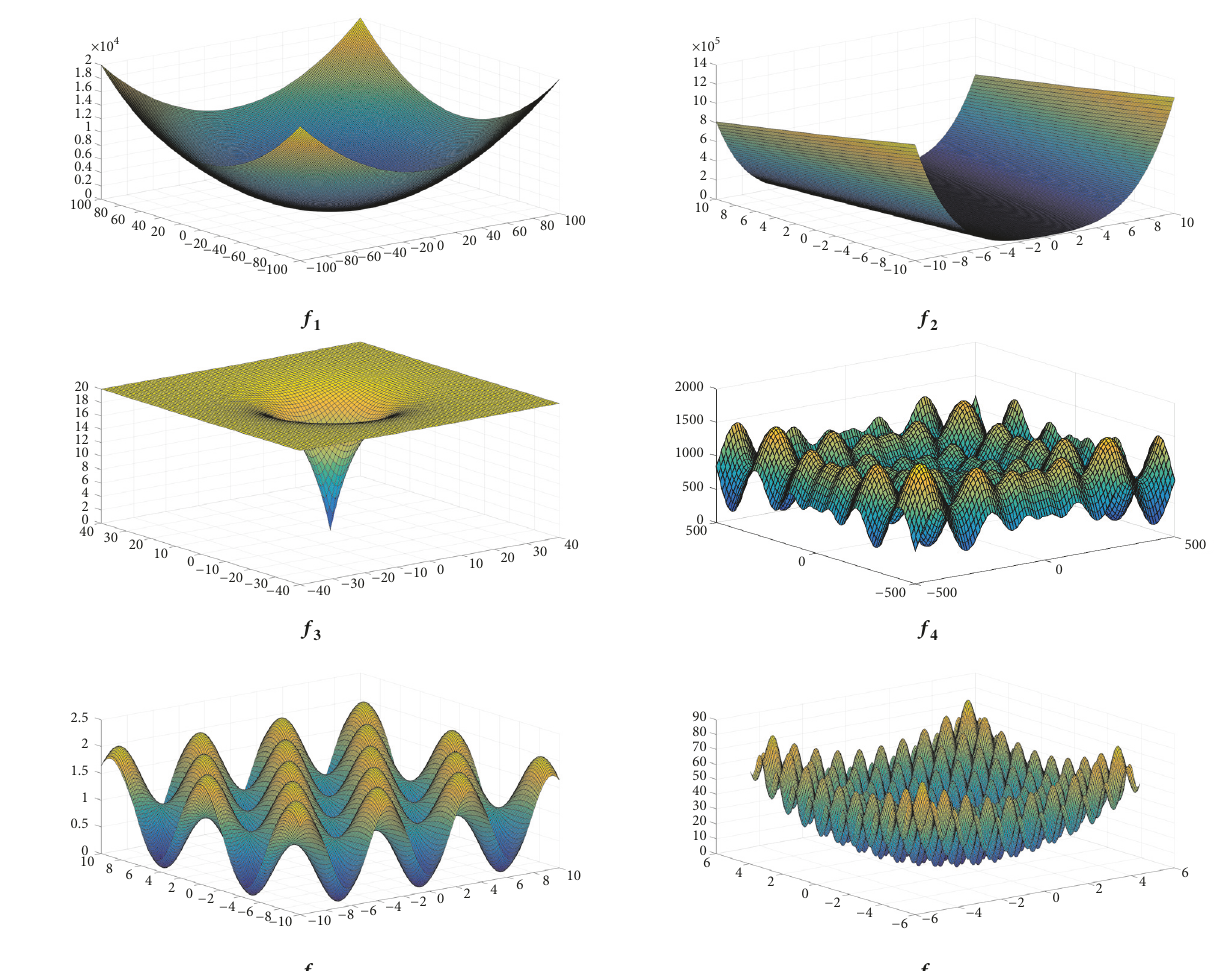
Figure 4: Objective function landscape of the 6 benchmark functions for D